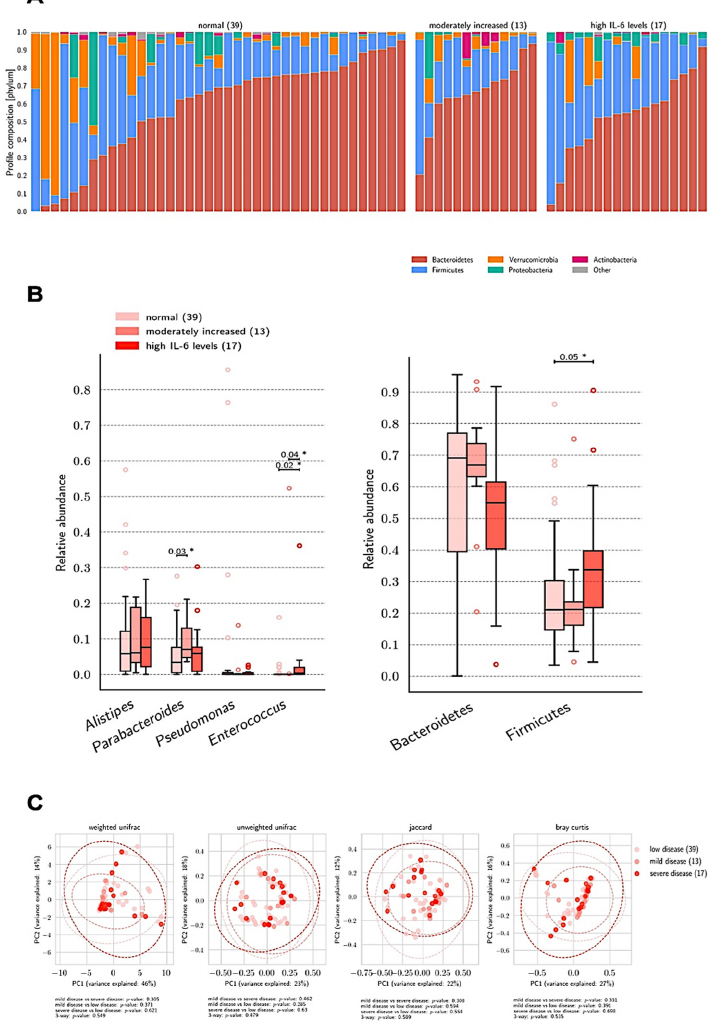
Figure 2. Bacteria relative abundance at phylum and genus levels, beta diversity, and profile composition according to IL-6 levels. ( A ) General profile composition of samples at phylum level was similar among groups. ( B ) Relative abundance analysis did not differ at phylum level but showed higher levels of Enterococcus among patients with high IL-6 levels compared with those with moderately increased and normal IL-6. ( C ) PCoA plots of beta diversity between the three groups did not show significant differences. IL-6 measurement was available in 69 (84%) patients. IL-6 levels were reported as normal range (<15 pg/mL), moderately increased (15–59 pg/mL), and high ( ≥ 60 pg/mL). Statistical significance reported as * p ≤ 0.05.